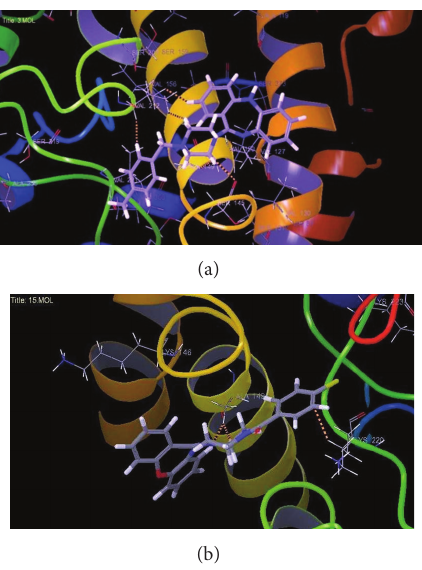
Figure 10: (a) Interaction of MJ 16 and (b) Interaction of MJ 37 with 5-HT 2A